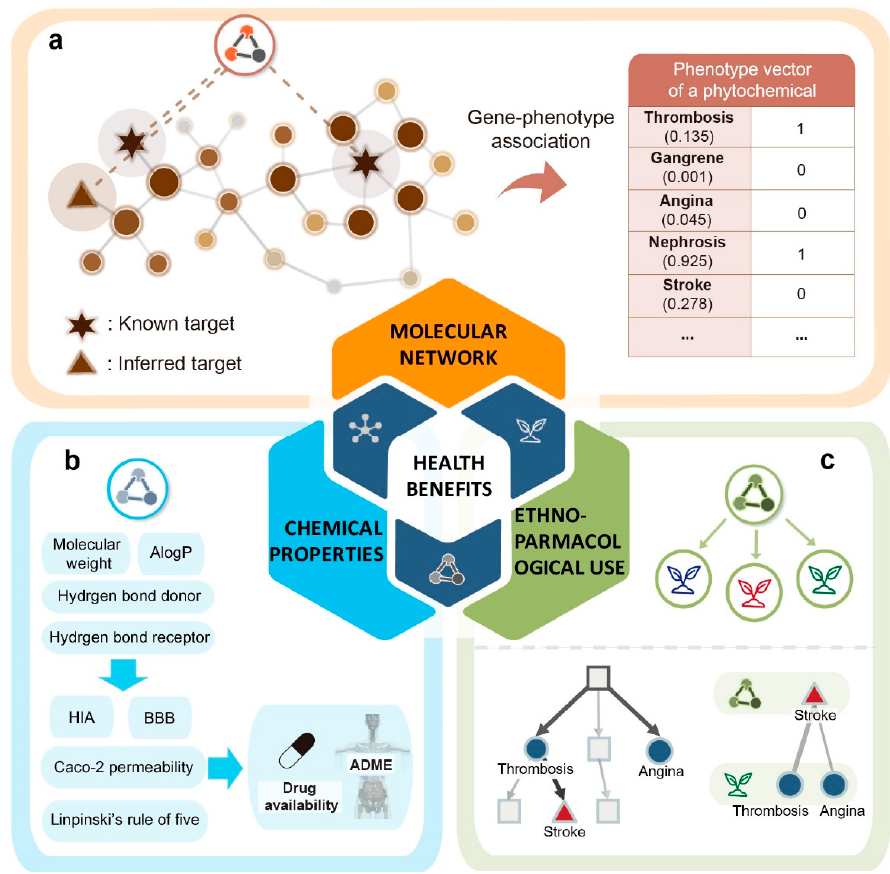
Figure 1. A systematic pipeline for the prediction of the health effects of phytochemicals. ( a